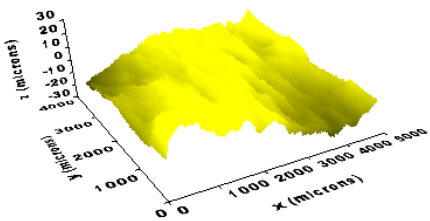
Fig.1. Microtopography of an asphalt mixture.